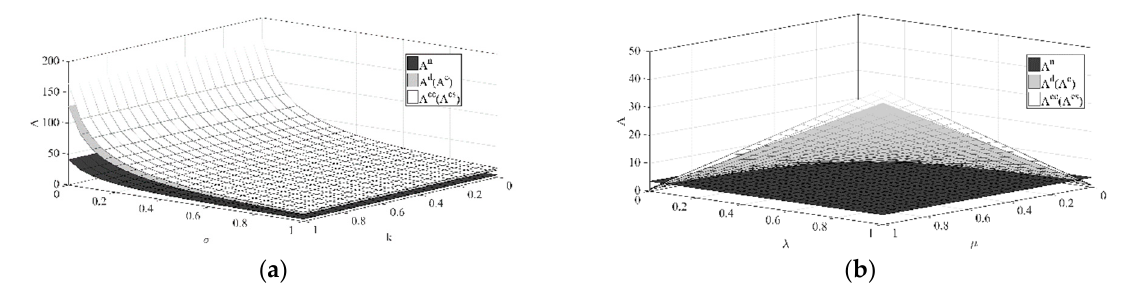
Figure 5. The impact of effectiveness parameters on the retailer’s low-carbon publicity investment. ( a ) The effect of σ and k . ( b ) The effect of λ and µ .